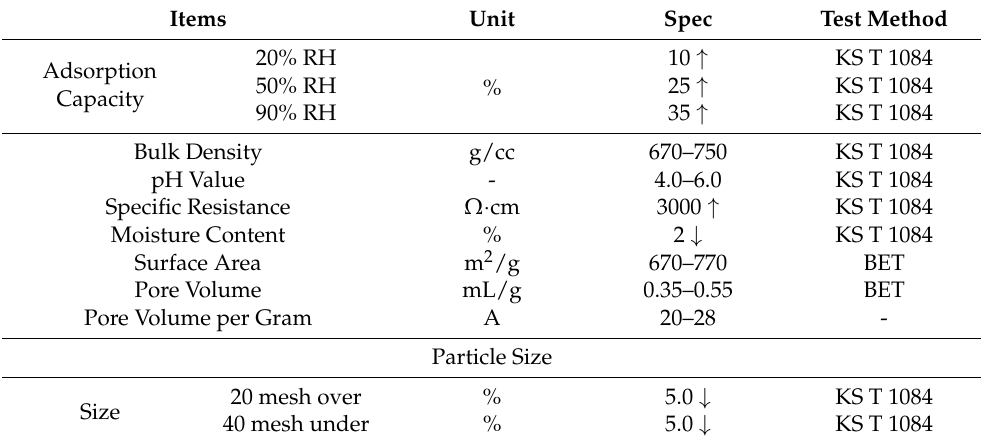
Table 1. Silica gel specifications.